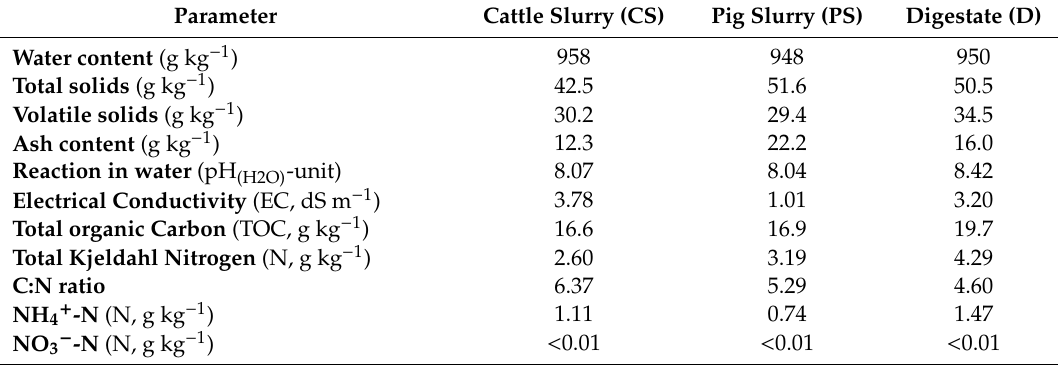
Table 2. The main physical and chemical characteristics of the cattle slurry (CS), pig slurry (PS), and digestate (D) used in the study (data are expressed on a wet